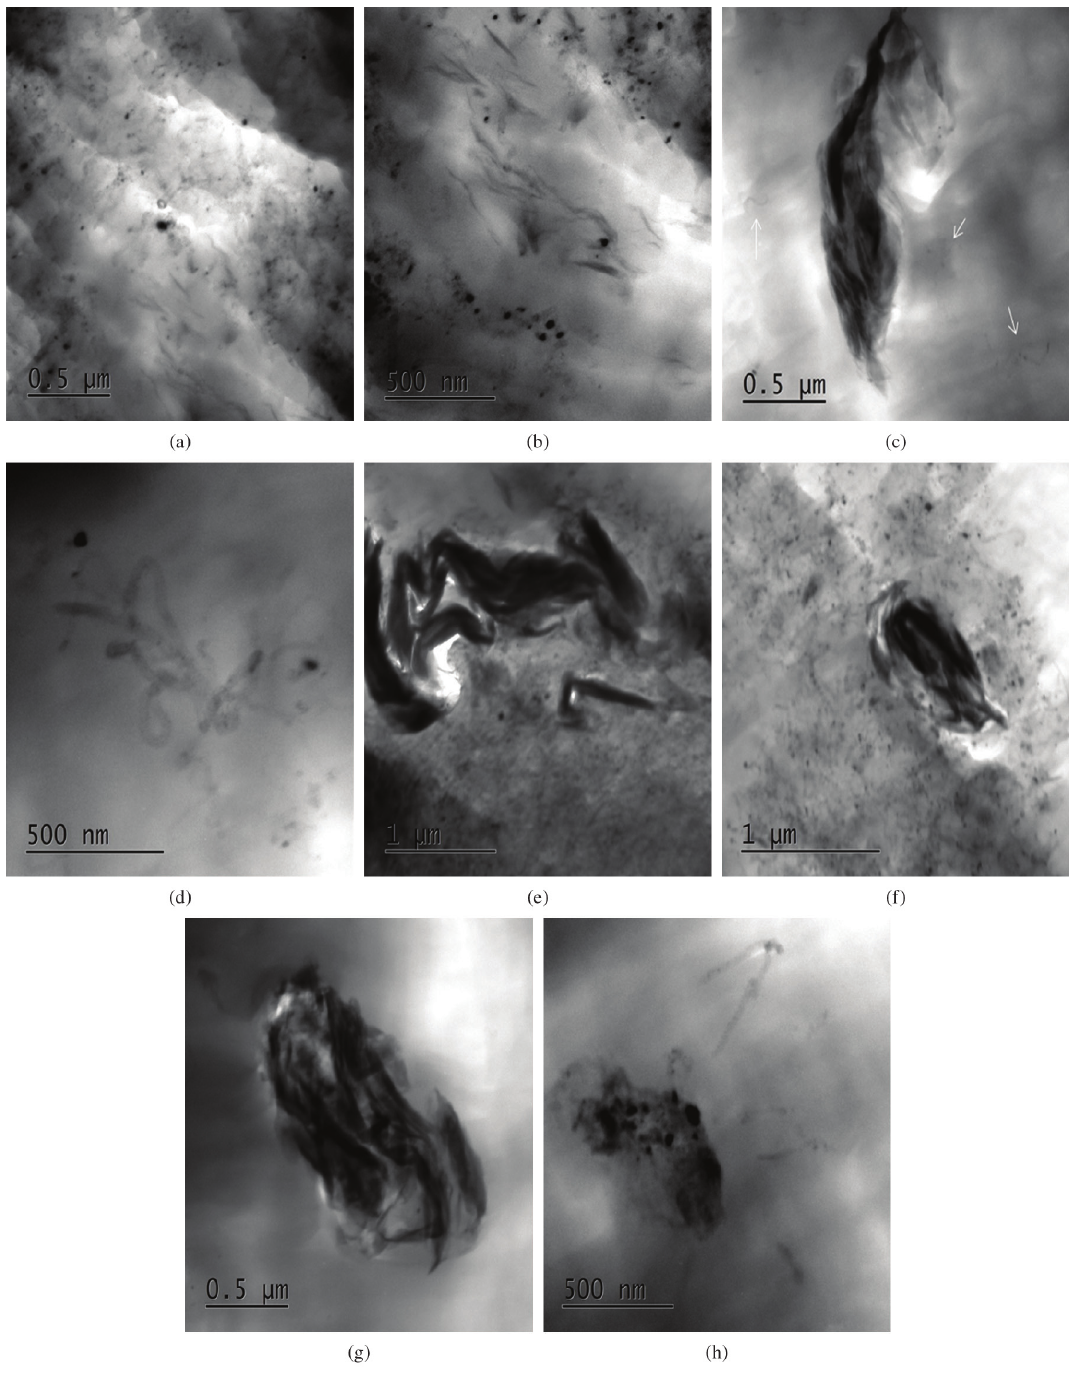
Figure 2. TEM micrographs of (a) and (b) PE30BNCs; (c) and (d) PE30bNCm; (e) and (f) PENaNCs; (g) and (h)